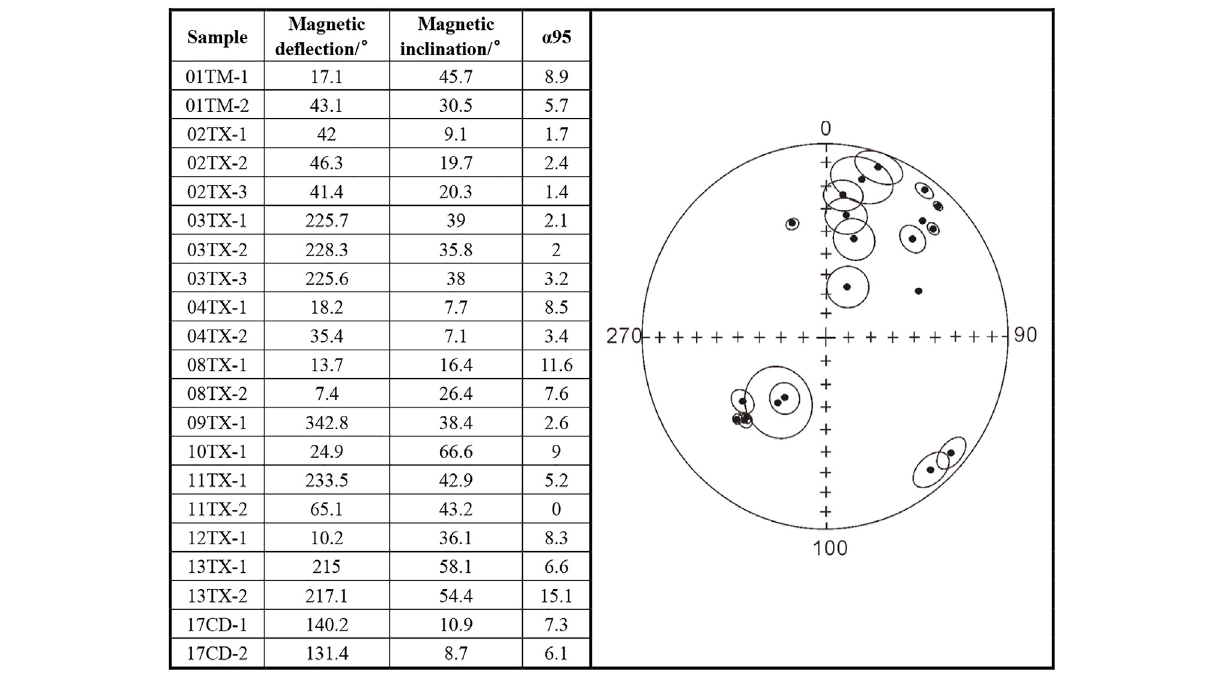
Frontiers in Earth Science |